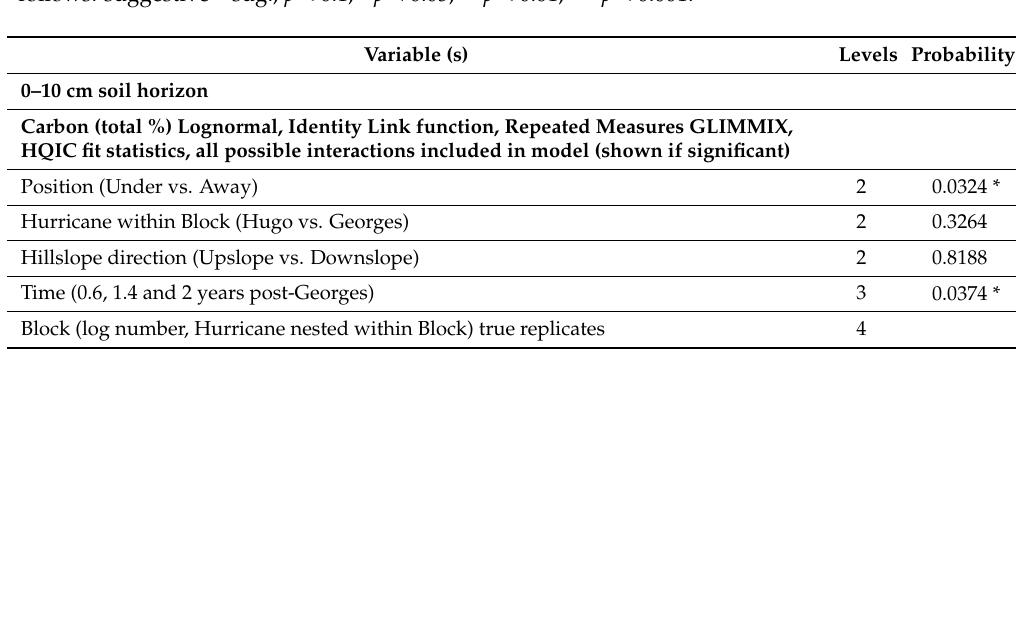
Table 3. Summary of the best fit statistical analysis models and results. Probability annotations are